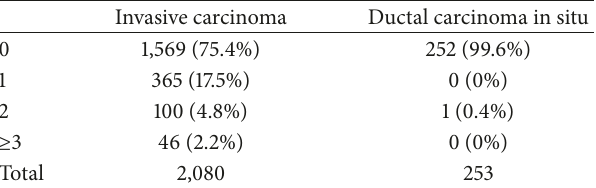
Table 4: Positive sentinel lymph nodes by